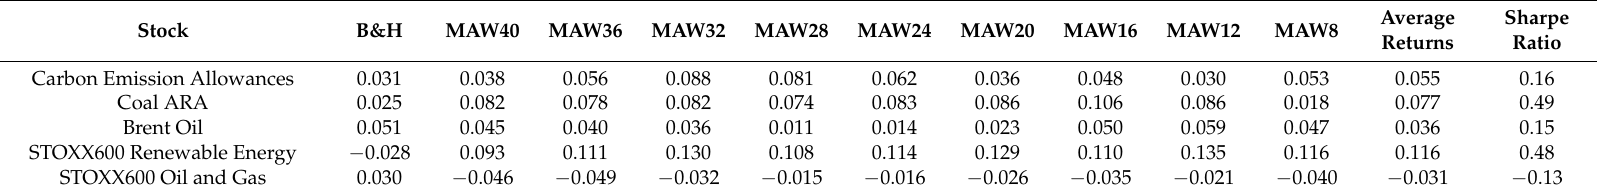
Table A2. Annualized daily (every fifth trading day) returns of MAW8–MAW40 (W = number of weeks), average returns and Sharpe ratios.